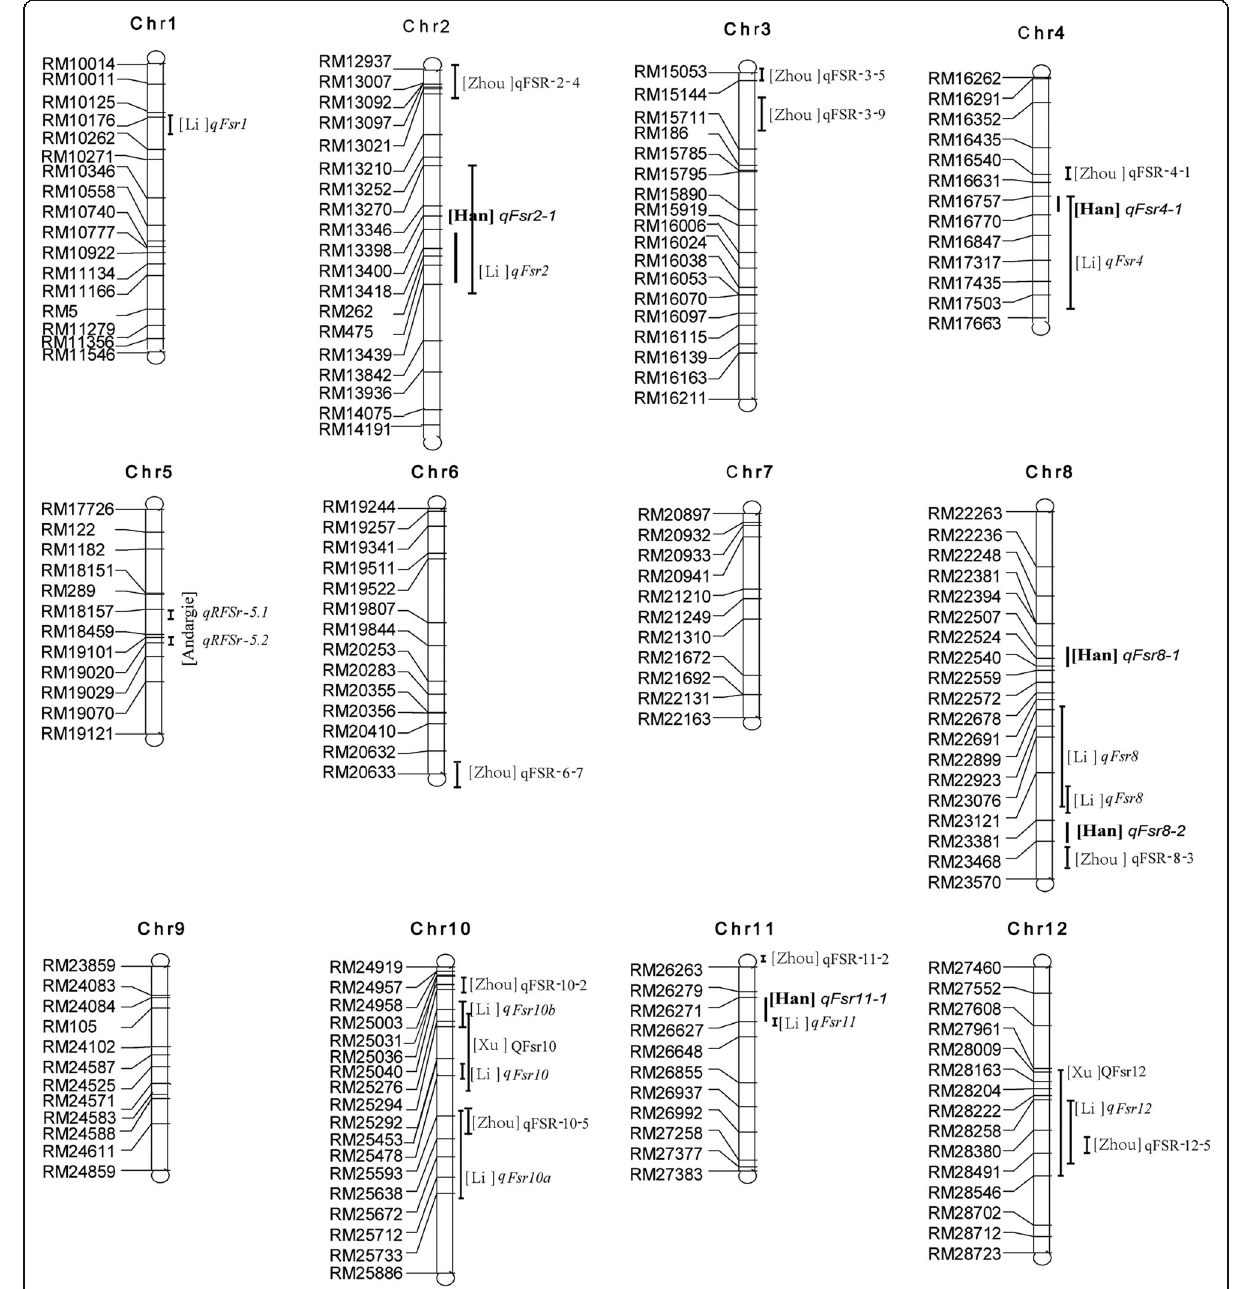
Fig. 3 Construction of genetic map and comparisons of genome locations of QTLs for false smut resistance identified in this and previous